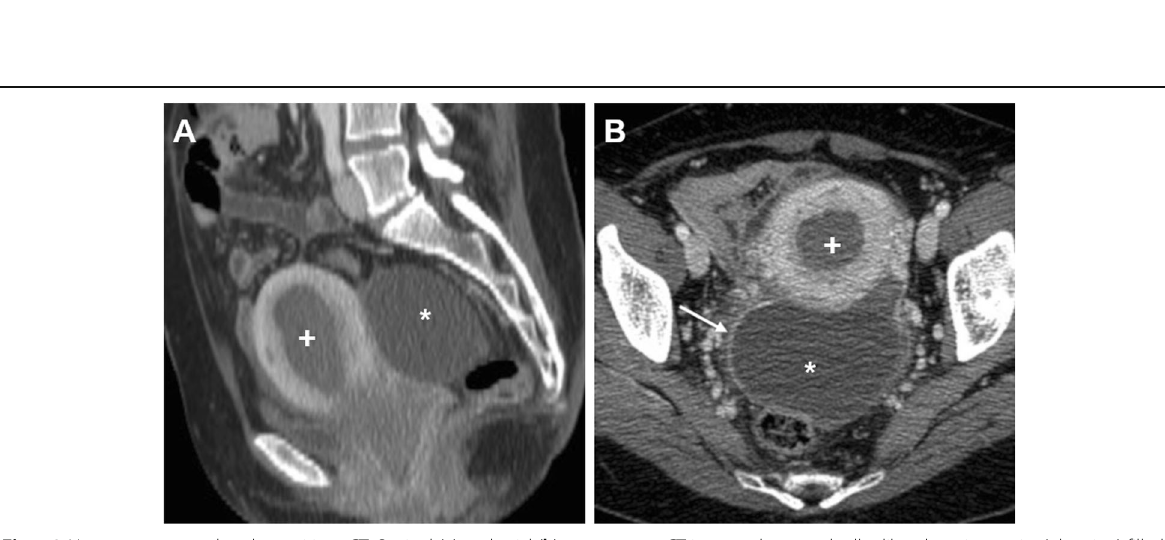
Fig. 10 Haematometra and endometritis at CT. Sagittal ( a ) and axial ( b ) postcontrast CT images show markedly dilated uterine cavity (plus sign) filled by heterogeneous fluid. Associated loculated effusion (asterisk) in the pelvic cul-de-sac with thin serosal hyperenhancement (thin arrow in b